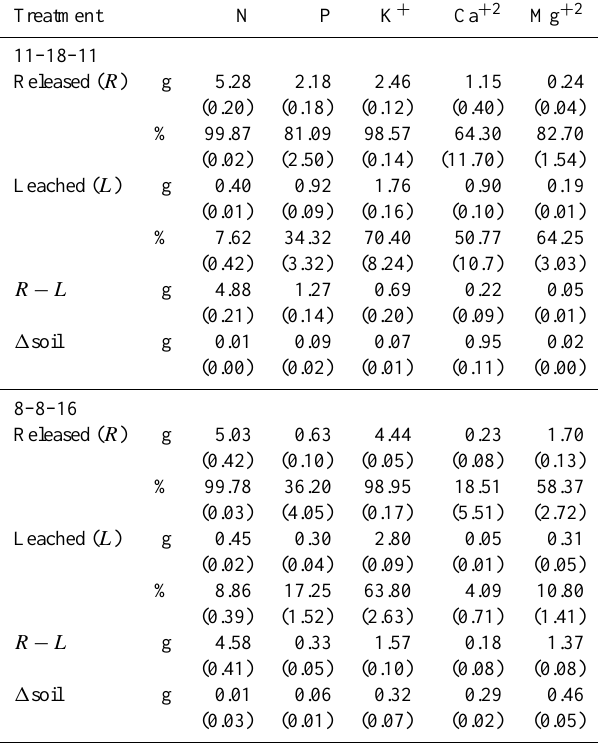
Table 4. Quantity and percentages of elements released ( R ) and leached ( L ) from the tablets at the end of the experiment (average values of three replicates, with standard deviation in